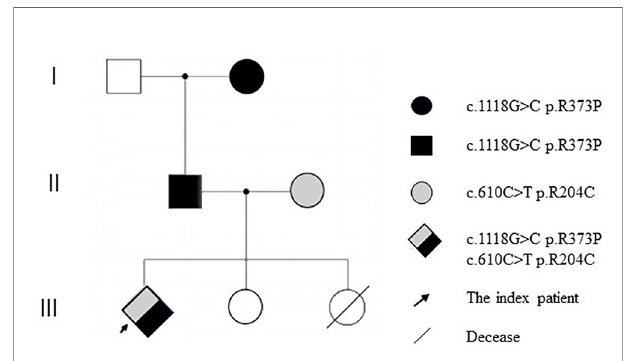
FIGURE 3 | Pedigree of CARD9 mutations (Due to death, no genetic analysis was performed for the second